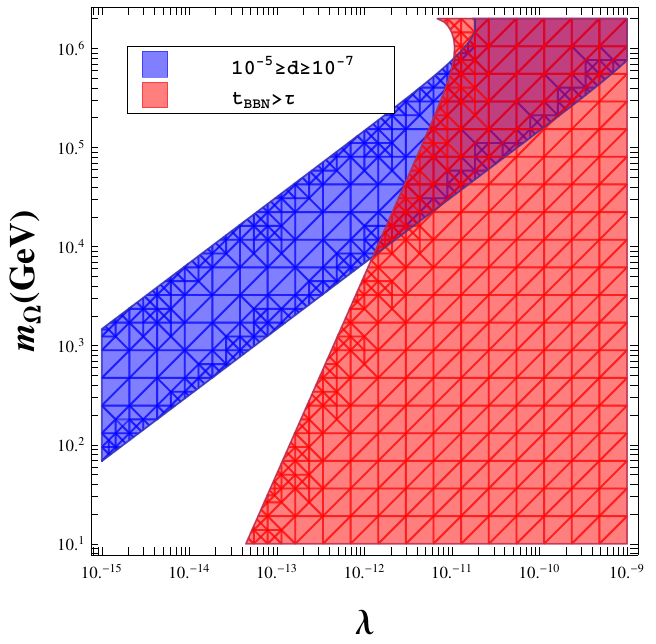
Figure 5 . Allowed parameter space from the requirement of producing correct dilution factor along with BBN constraints on